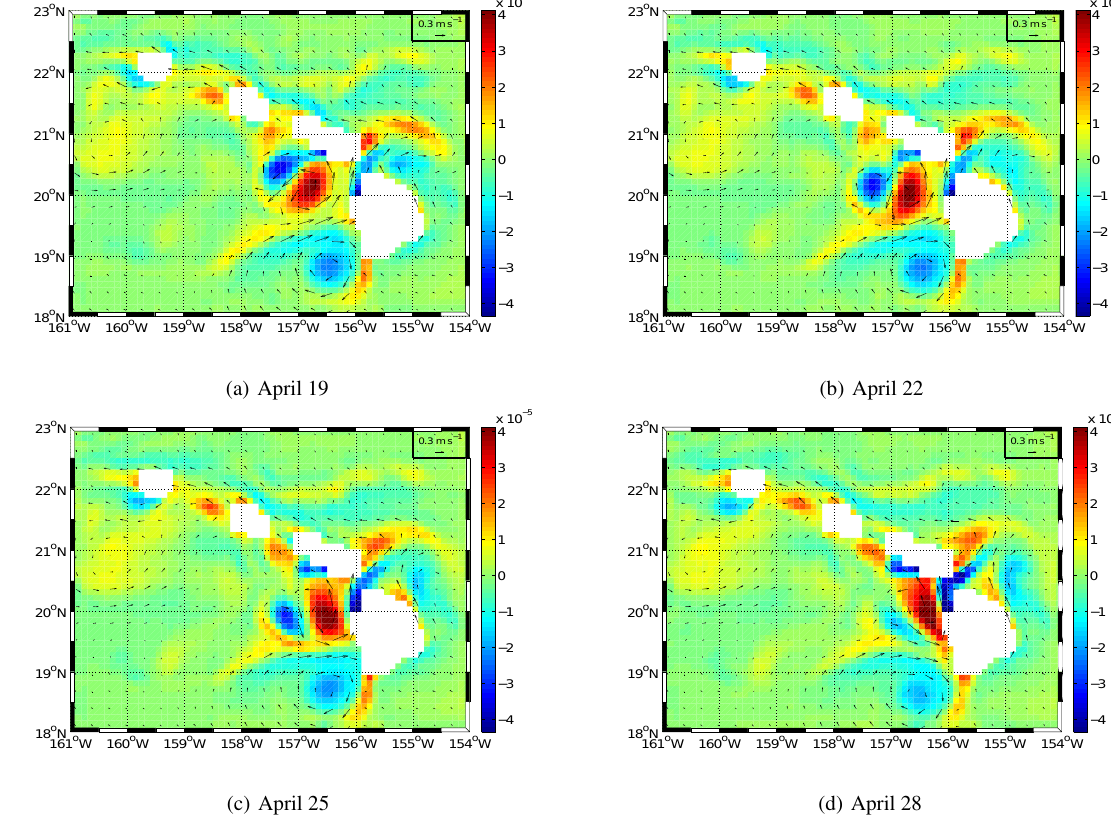
Fig. 6. Relative vorticity field and velocity vectors for Run-C at 10-m depth at different dates in April.